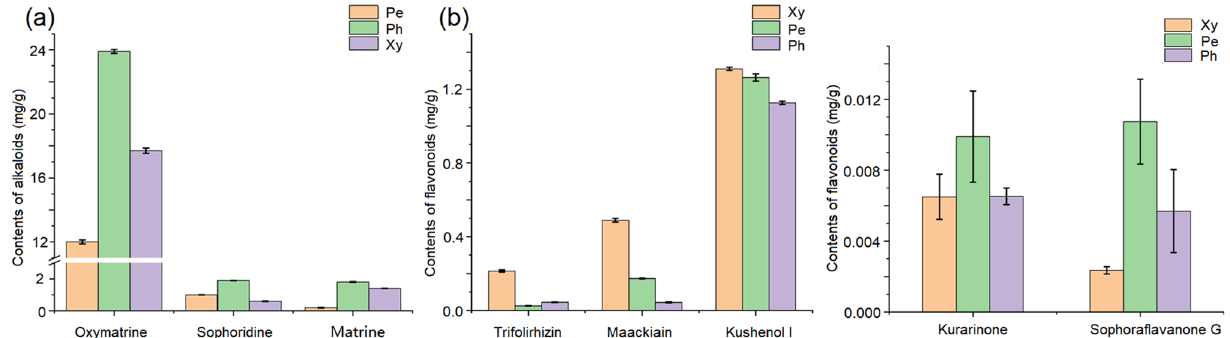
Figure 2. Contents of alkaloids and flavonoids in the root tissues of S. flavescens . ( a ) Contents of three alkaloids. ( b ) Contents of five flavonoids. Pe, Ph, and Xy represent the periderm, phloem, and xylem, respectively.